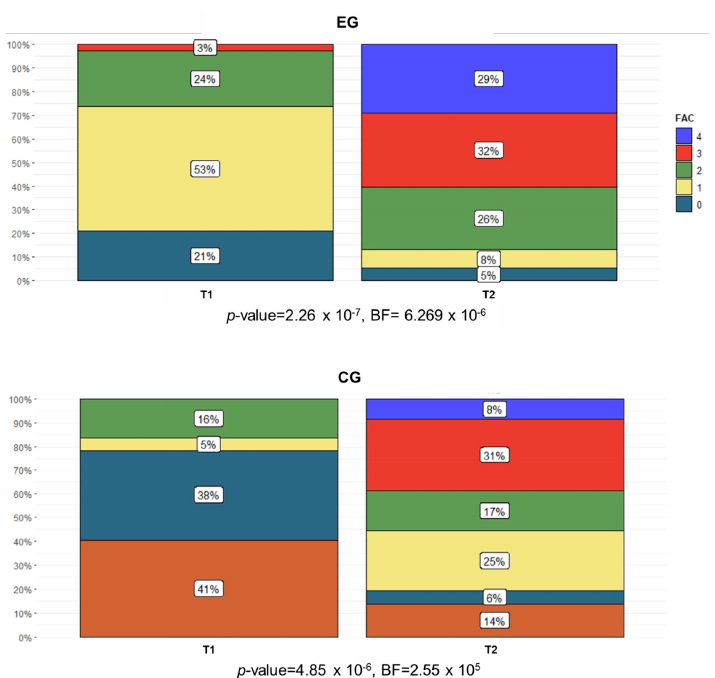
Figure 7. Percentage of subjects in each FAC category (0 = subject cannot walk; 1 = subject requires physical assistance from one person and contacts are continuous; 2 = subject requires physical assistance as in the previous category, but contact is intermittent or light; 3 = subject requires verbal supervision or standby help from one person without physical contact; 4 = subject can walk independently on level ground but requires help on stairs, slopes, or uneven surfaces; 5 = subject can walk independently anywhere) in both the EG and the CG at T1 and T2.